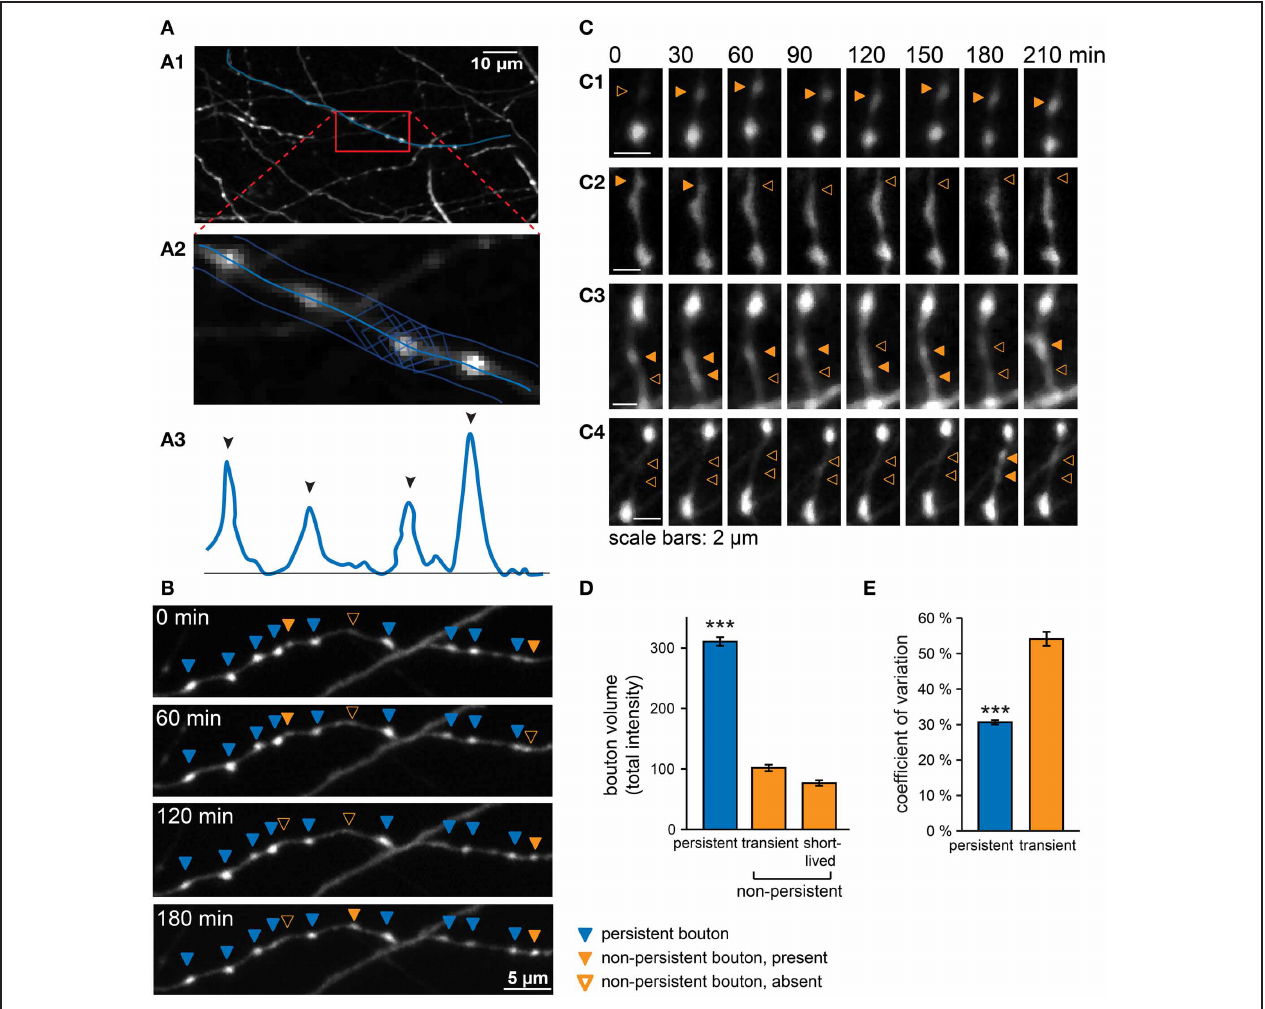
FIGURE 1 | Analysis of GABAergic boutondynamics showing persistent and non-persistent GABAergic boutons. (A) Boutons were located and analyzed in a semi-automatic manner with custom-written Matlab software. (A1) An axon was selected in the raw image data, and a3D-curve was fitted through the axon. (A2) The summed intensity in orthogonal planes along the fitted curve was determined and used to generate a 3D intensity profile of the axon (A3) . Black arrowheads indicate automatically detected peaks of the intensityprofileabovethreshold. (B) Time-lapseimagingdatafromaGABAergic axon, showing persistent (blue arrowheads), and non-persistent boutons (closed orange arrowheads: bouton is present; open orange arrowheads: